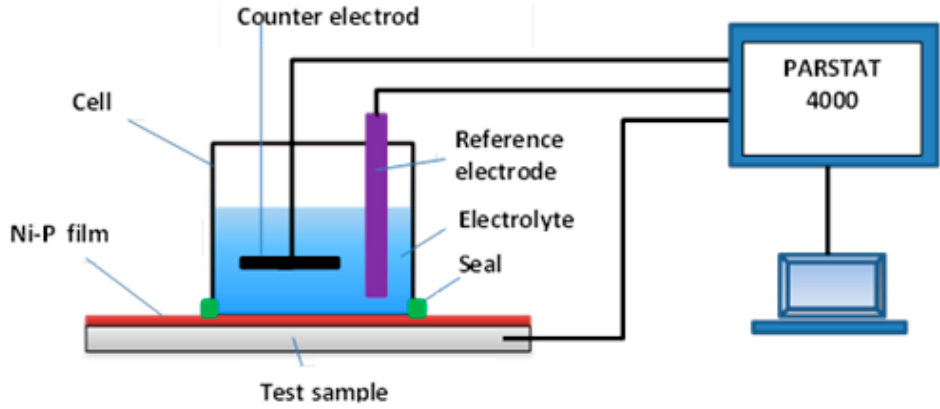
Figure 1. Scheme of the system for measuring the resting potential.